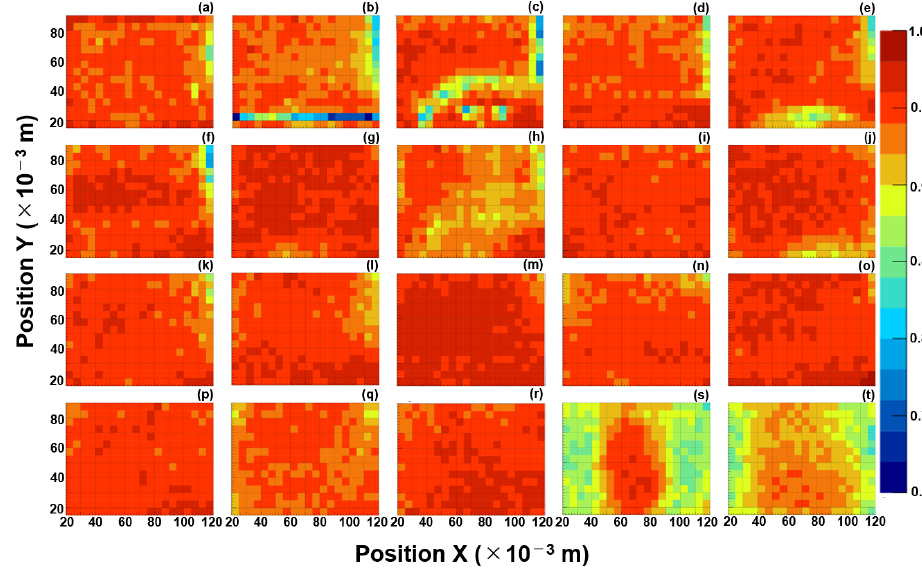
Figure A1. The position distribution of the fill factor in each film of ECC02. (a) – (t) represent PL01–PL20,